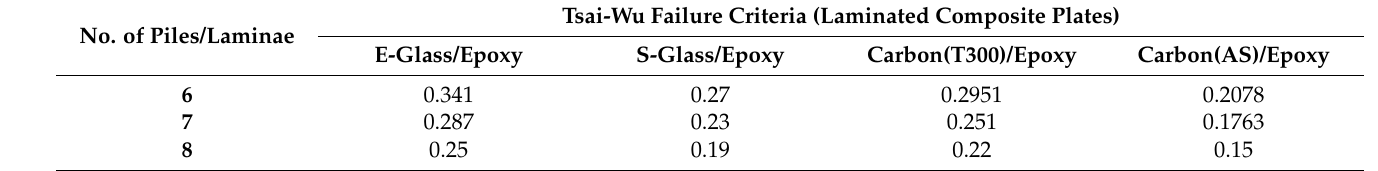
Table 3. Results of Tsai-Wu failure criterion under 200 kN longitudinal and 100 KN transverse loading.